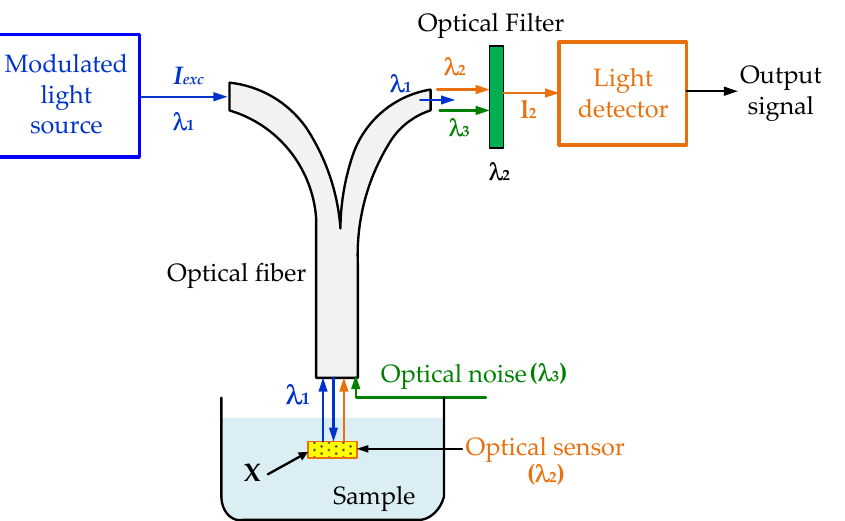
Figure 8. Instrumentation setup for an extrinsic optical fiber sensor used for measuring light intensity.